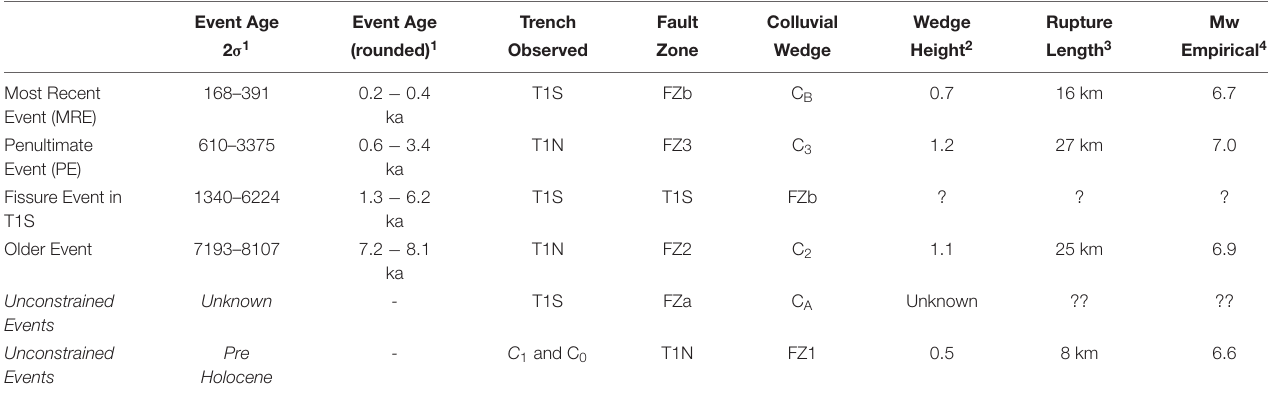
TABLE 3 | Modeled event ages and earthquake inferences for the TR site. Event